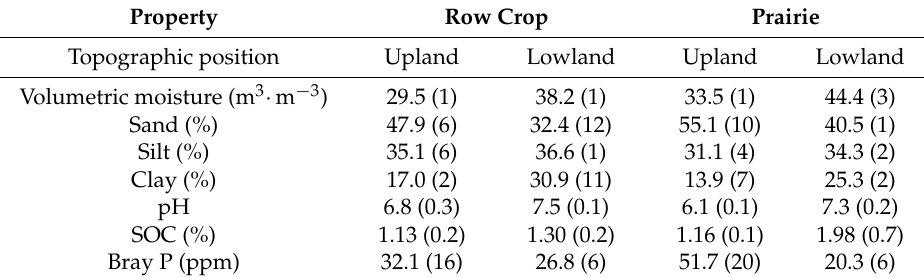
Table 1. Soil properties in upland and lowland row crops and prairies (mean with standard